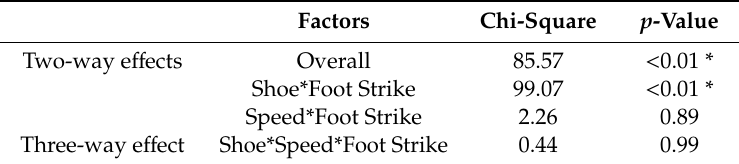
Table 2. K-way e ff ect and partial